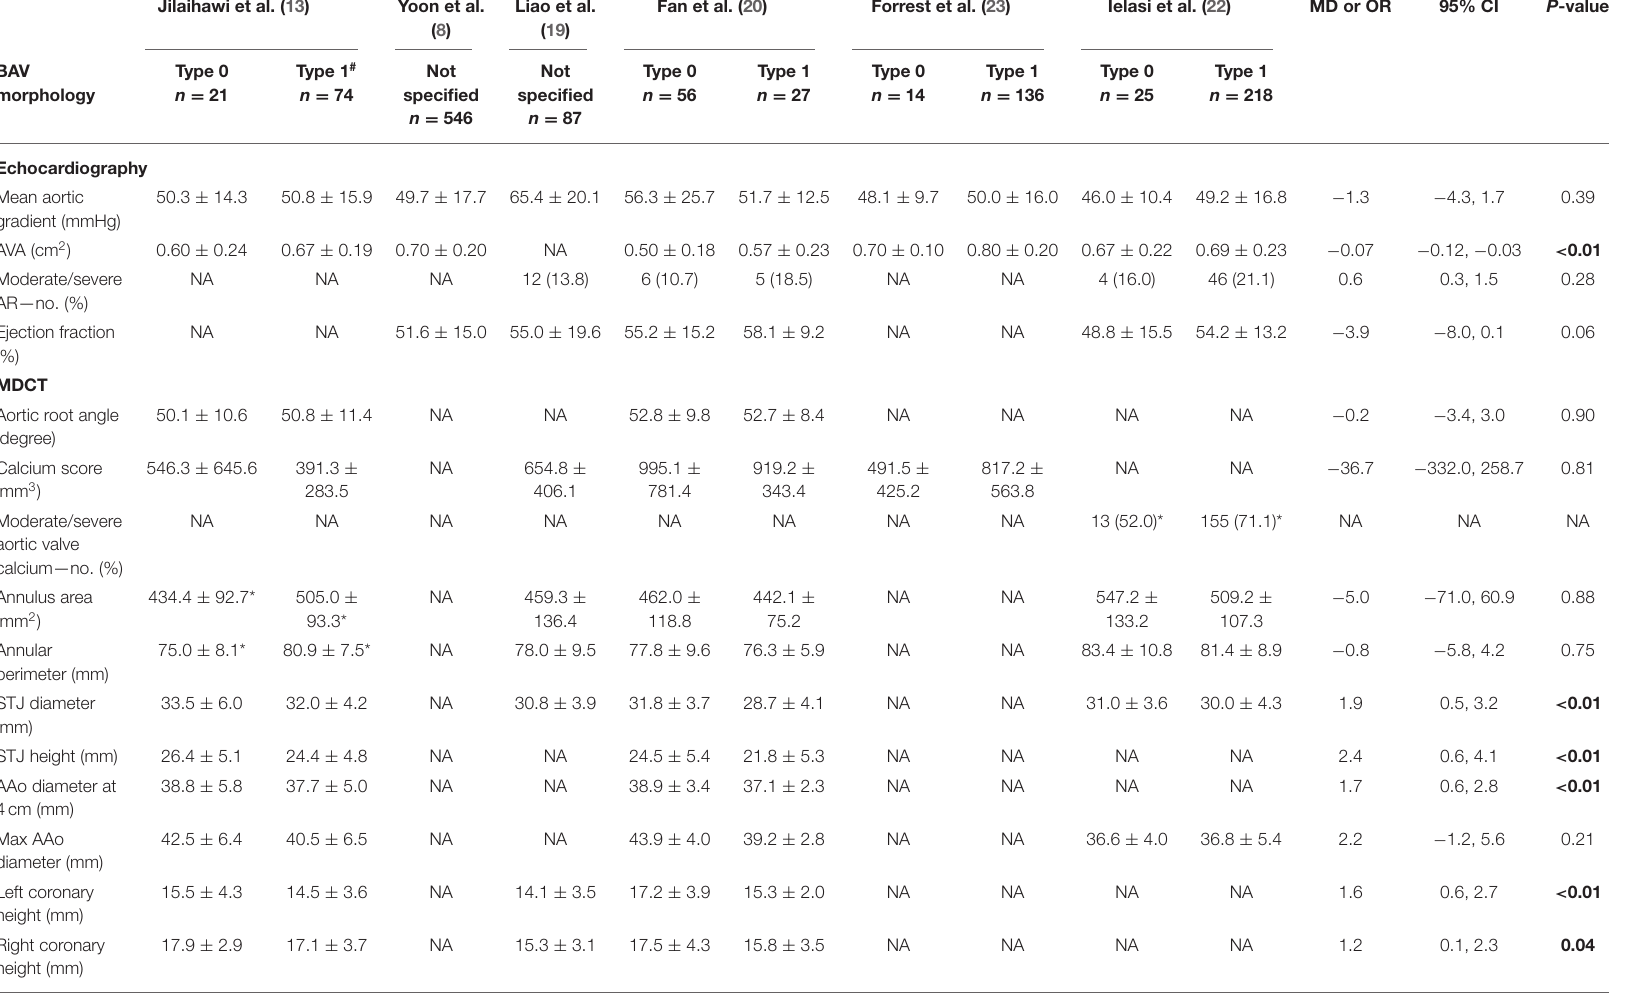
TABLE 4 | Imaging findings.